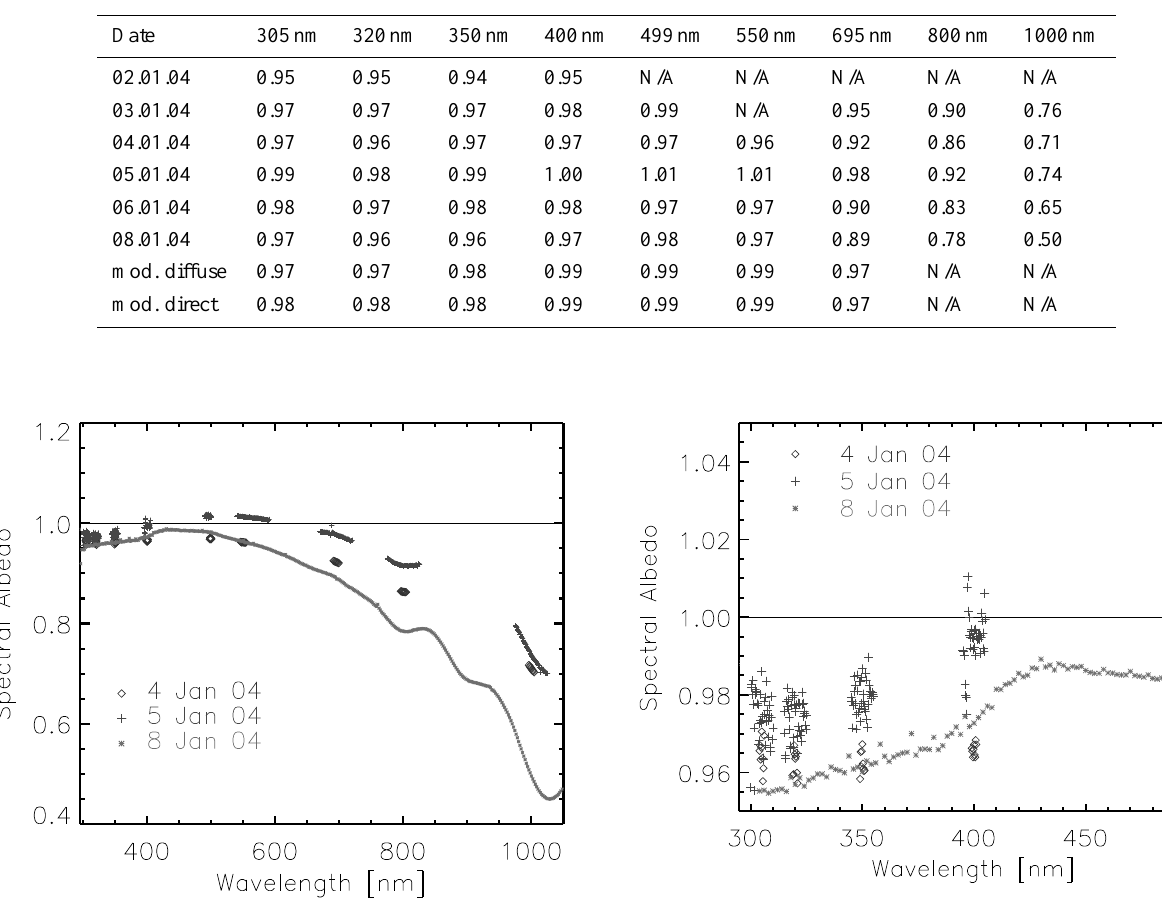
Table 4. Daily mean spectral albedo at different wavelengths measured at Neumayer, Antarctica. Values of modelled direct and diffuse albedo are also included. The sampling protocols differed on each day. Therefore, the albedo for some wavelengths is not available (N/A) on some days.